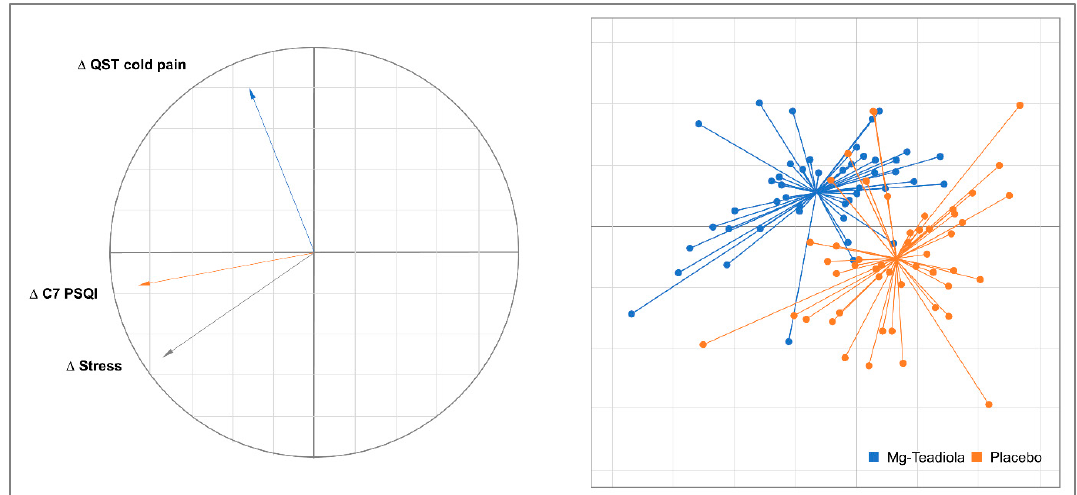
Figure 6. Factorial Discriminant Analyses. Δ denotes a change on Day 28 for all participants (both Mg-Teadiola and placebo groups) C7 PSQI, Component 7 (daytime dysfunction) of PSQI, Mg-Teadiola, combination of 150 mg Mg, 0.7 mg vitamin B6, 0.1 mg vitamin B9, and 1.25 µg vitamin B12, +222 mg of rhodiola extract and 125 mg of green tea extract including 50 mg of L-theanine; PSQI, Pittsburgh Sleep Questionnaire Index; QST, Quantitative Somatosensory Thermotest.